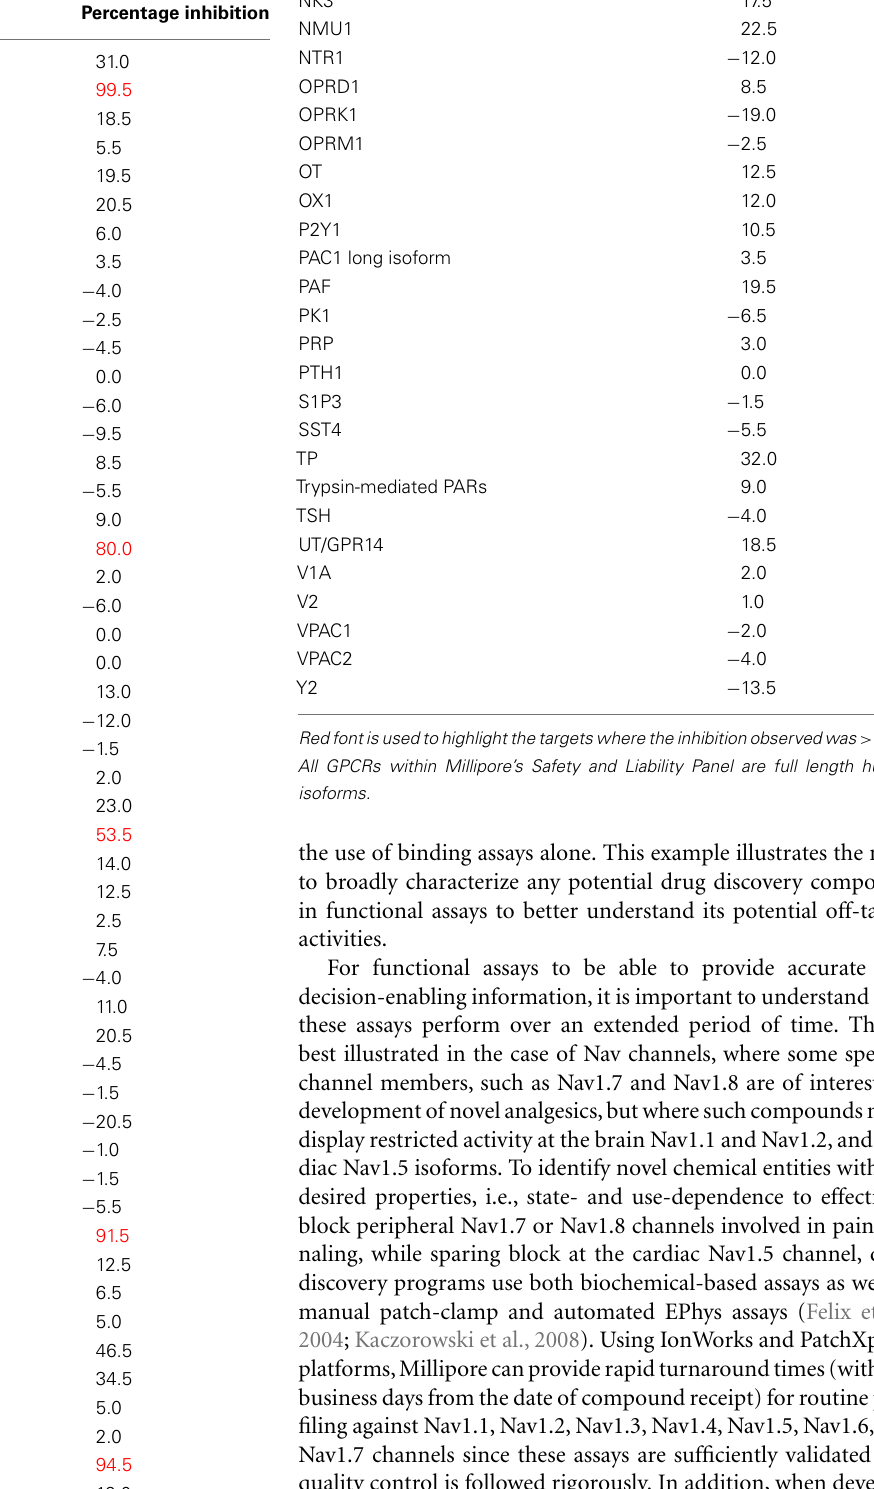
Table 2 |Activity expressed as percentage inhibition of 10 μ M BIRB0796 on 76 GPCRs within Millipore’s Safety and Liability